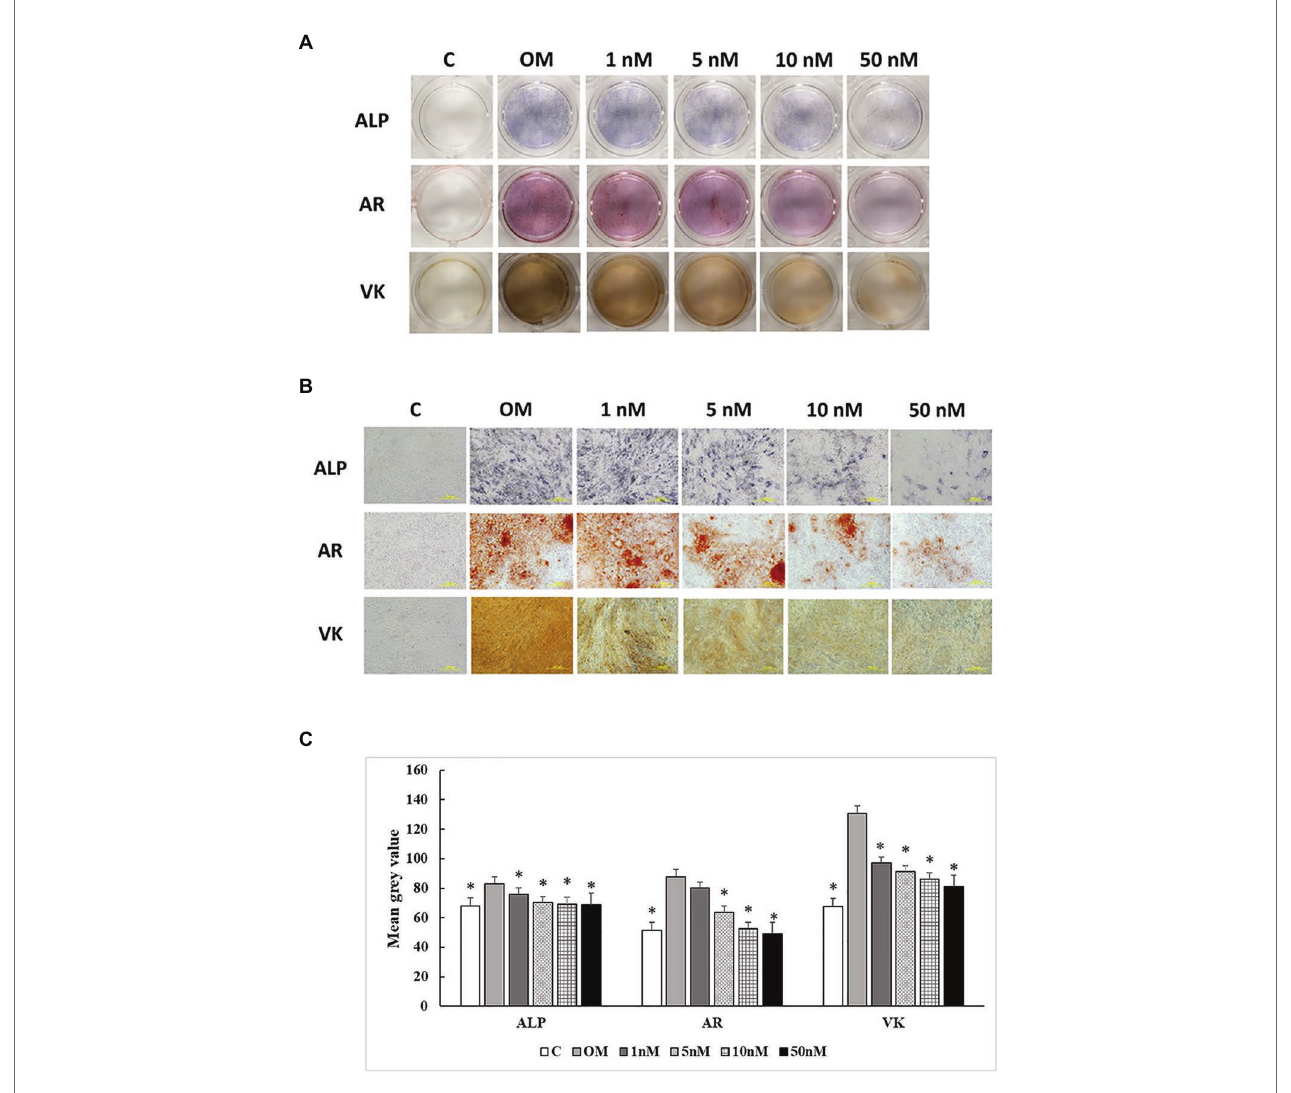
FIGURE 5 | Effects of 1,25OHD on chicken osteoblasts ALP activity and mineralization at 7 days. In each picture, the first row: ALP (Alkaline Phosphatase); the second row: AR (Alizarin Red stains the deposited minerals); and the third row: VK (Von Kossa stains for the deposited minerals). (A) Pictures were taken by DSRL camera, with same exposure setting across all the treatment. (B) The picture was taken under the microscope at 40x. The bar indicated 200 μ m. (C) The pictures (40x) were invert and converted to 8-bit gray scale using Image J software (1.48v version, U. S. National Institutes of Health, Bethesda, MD, United States). The mean gray value (0.16 mm 2 area) was measured. The values were presented as mean gray value. The higher value represents darker staining (Value means ± SEM, three replicates/treatment; * means significant difference compared to OM; ALP: p < 0.0001; AR: p < 0.0001; VK: p <